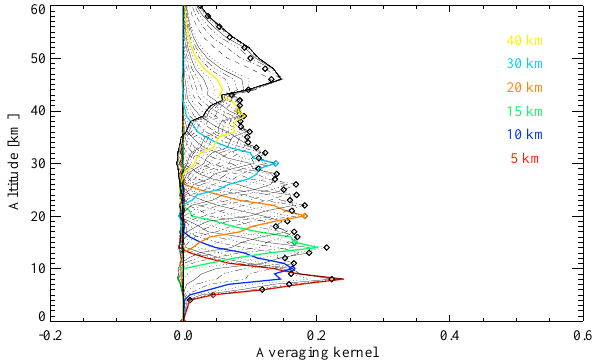
Fig. 5. As Fig. 1 but for HCN.